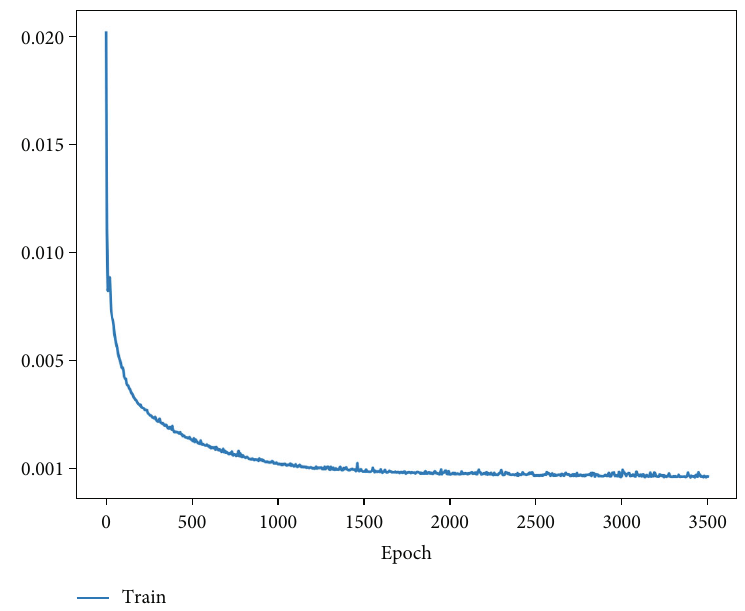
Figure 13: Variation of loss function during training and testing.